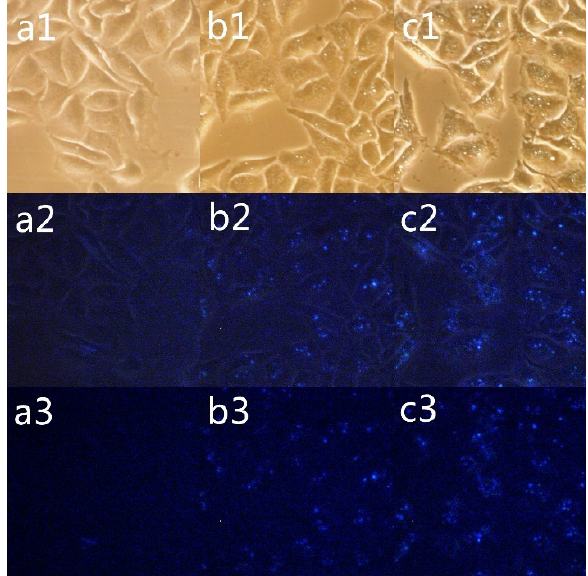
Figure 1. Inverted fluorescent microscope images of SMMC-7721 cells. The cells were incubated with 20 µM CPT (a1–a3), 10 µM E2 (b1–b3), or 20 µM E2 (c1–c3) or for 4 h at 37